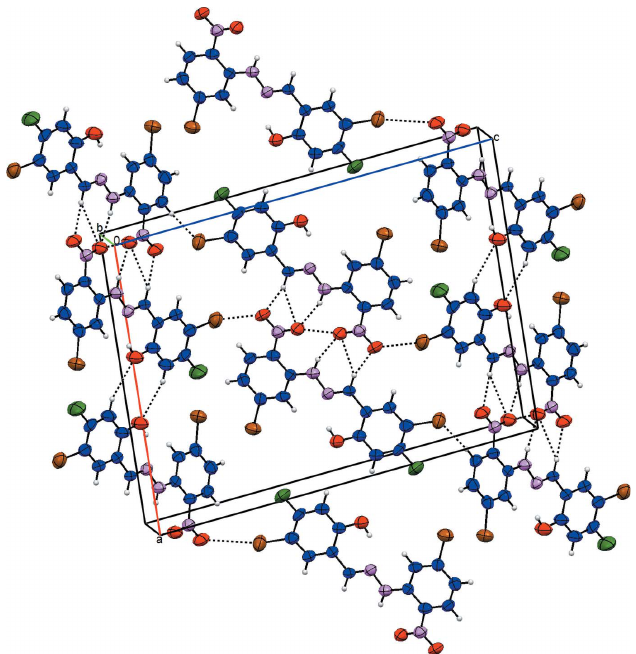
Figure 2 The view of the crystal packing of the title